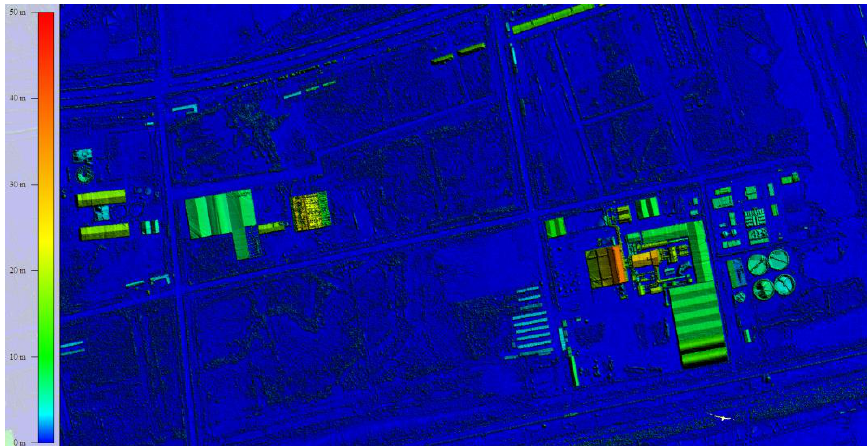
Figure 3. DSM information derived from LiDAR point cloud data.